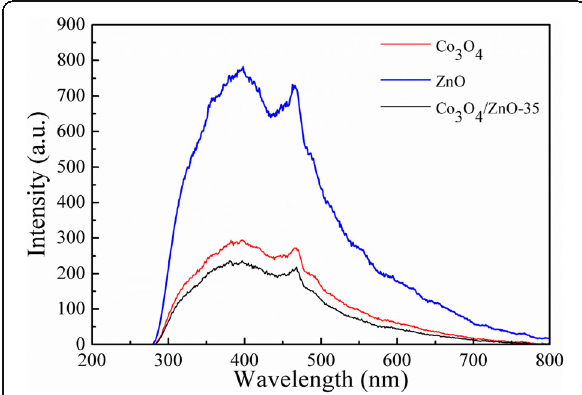
Fig. 13 Room temperature PL spectra of the synthesized Co 3 O 4 , ZnO, and Co